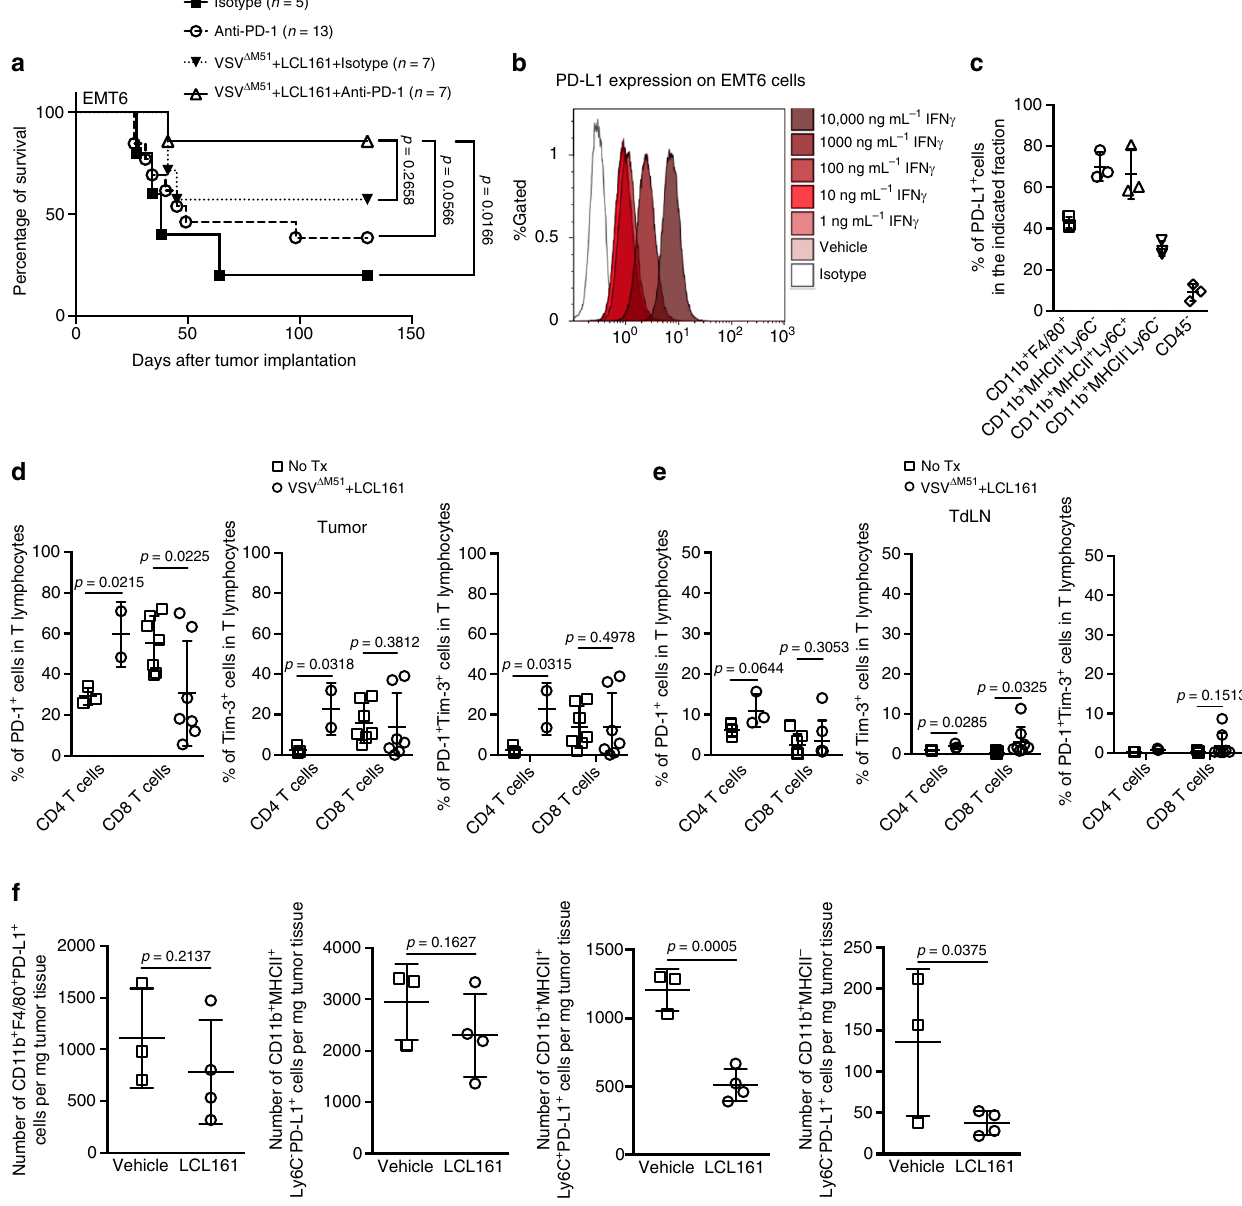
Fig. 6 LCL161 and VSV Δ M51 combination therapy synergizes with α PD-1 therapy. a Overall survival of EMT6 tumor-bearing mice treated with LCL161 + VSV Δ M51 ± PD-1 antibody (or isotype control; duplicate experiments; log-rank test). b PD-L1 expression on EMT6 cells treated for 24h with IFN γ (or vehicle) at the indicated concentrations, measured by fl ow cytometry ( n = 3 biological replicates, single experiment). c PD-L1 expression on the indicated populations of cells isolated from 12-day-old EMT6 tumors (single experiment; mean ± SD). d , e Membrane staining for PD-1 and Tim-3 expression on CD8 + and CD4 + T cells isolated from EMT6 tumors d and TdLN e 7 days post treatment, measured by fl ow cytometry (duplicate experiments; mean ± SD; t- test). f PD-L1 expression on the indicated populations of TAM isolated from EMT6 tumors 72h post TX (single experiment; mean ± SD; t